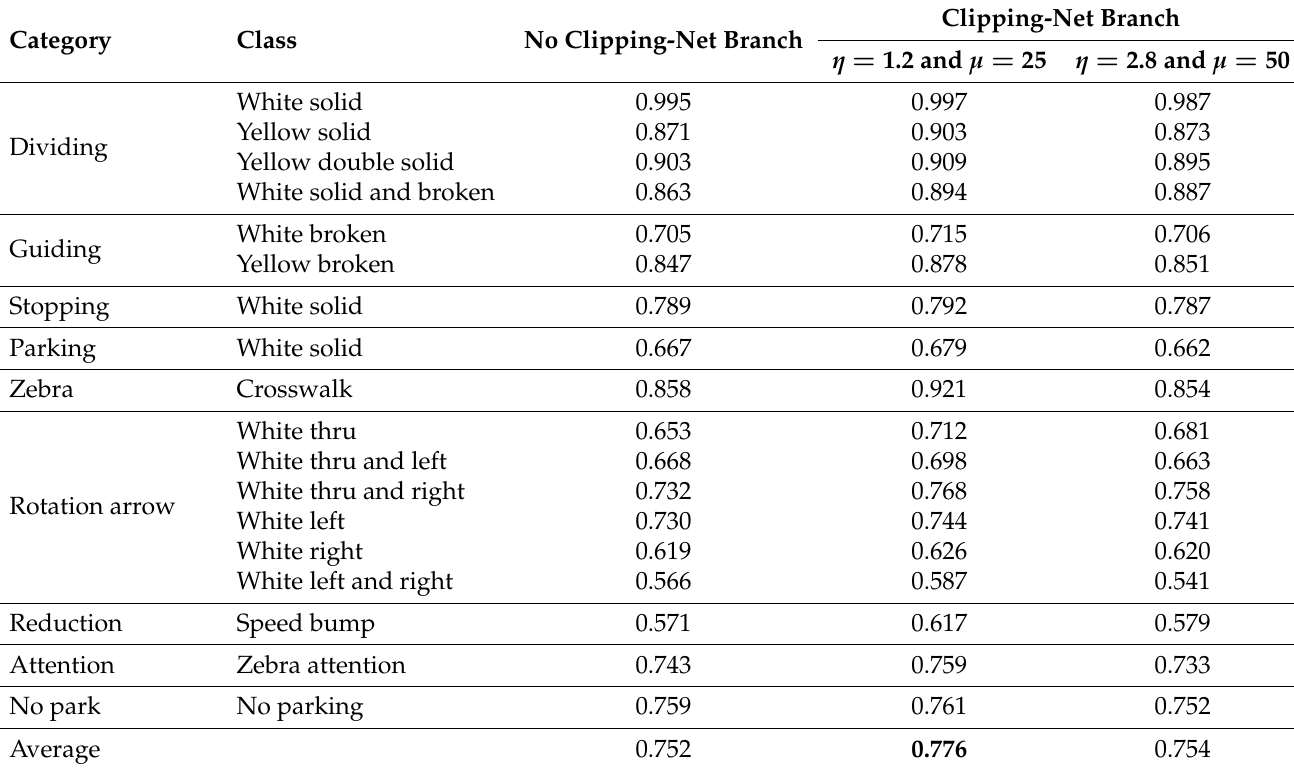
Table 3. The mIoU of our model that removes the Clipping-net branch and our model that contains the Clipping-net branch in each